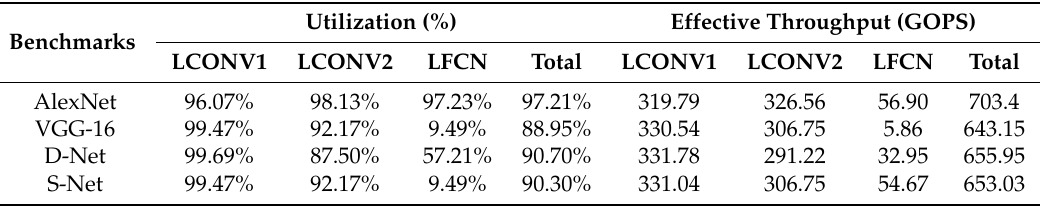
Table 3. Detailed performance of each computing unit under the optimal dataflow.